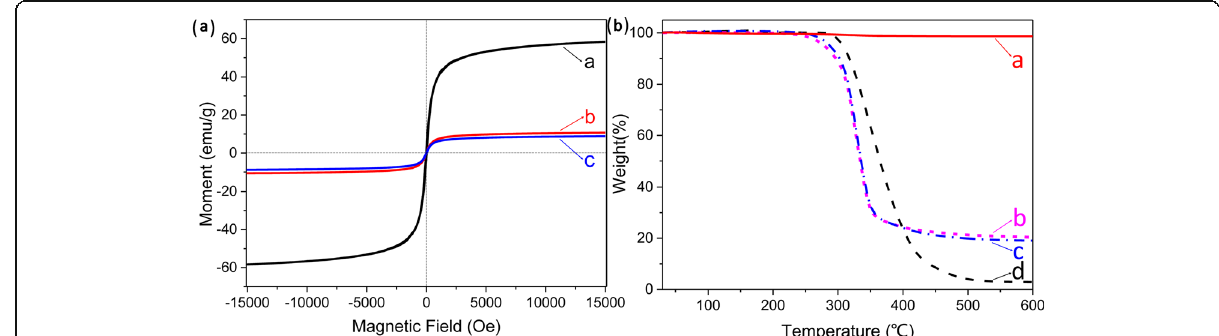
Fig. 6 a Field-dependent magnetization curves of ( a ) γ -Fe 2 O 3 NPs and γ -Fe 2 O 3 /PU composite fiber membranes prepared ( b ) with and ( c ) without the use of an auxiliary electrode at room temperature. b Thermogravimetric curves of ( a ) γ -Fe 2 O 3 NPs, γ -Fe 2 O 3 /PU composite fiber membranes